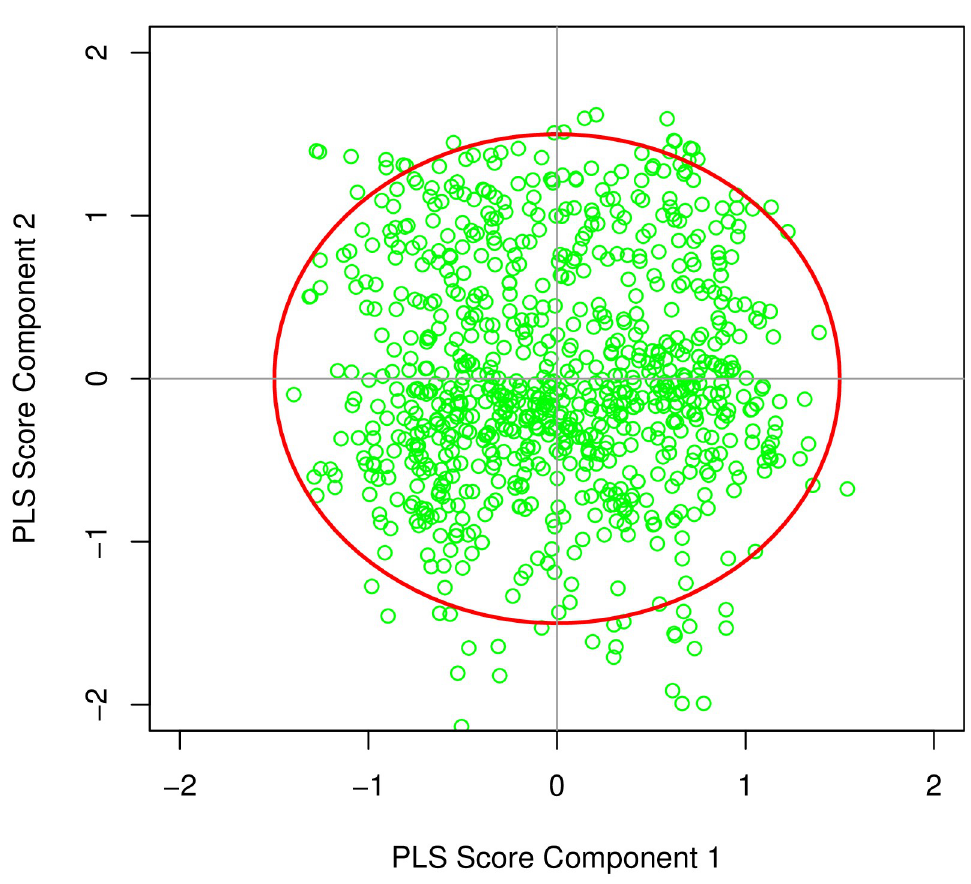
Fig 2. The PLS scores from component 1 and component 2 were plotted in the upper panel. Mothers laying out of red circle were considered outliers. For illustration purposes, the visualized graph showing several samples (mothers) grouped in one cluster is presented in the lower